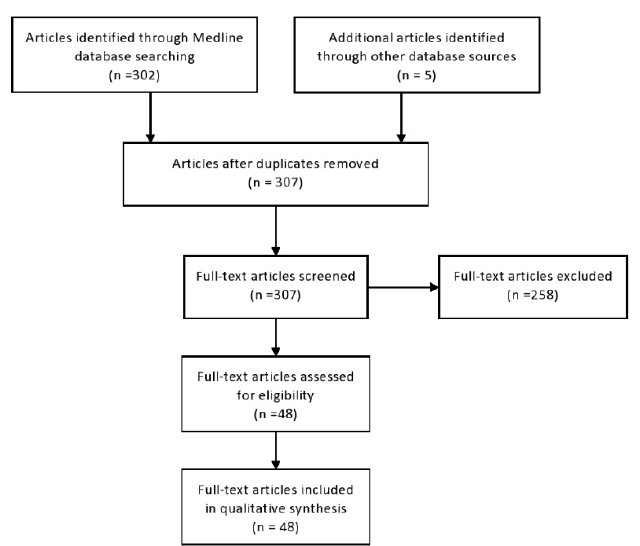
Figure 1. The Preferred reporting items for systematic reviews and meta-analyses (PRISMA) flow diagram. The PRISMA flow diagram shows the flow of information through the different phases of article selection.